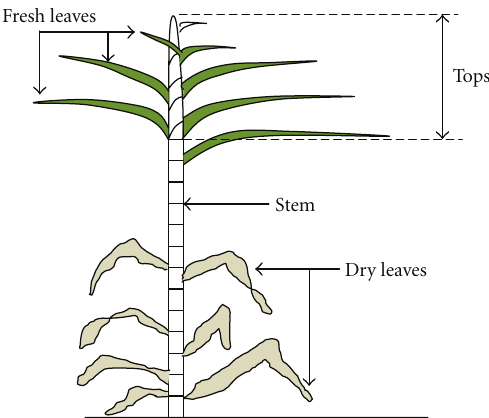
Figure 2: The sugarcane plant morphology. Adapted from